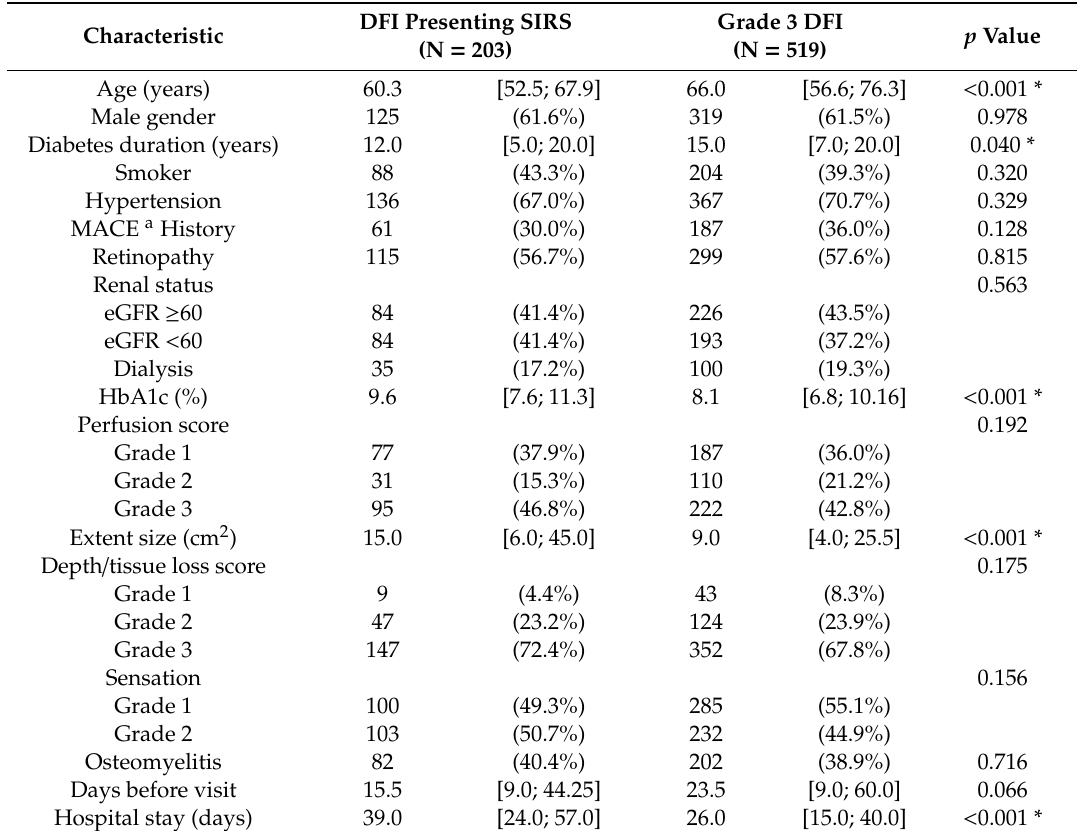
Table 1. Clinical characteristics and wound classification between severe and grade 3 diabetic foot infection